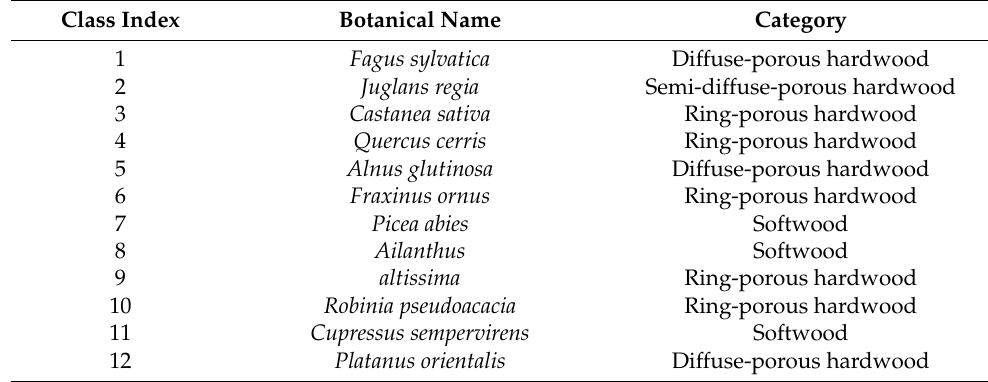
Table 6. Tree species in “Wood AUTH” dataset.